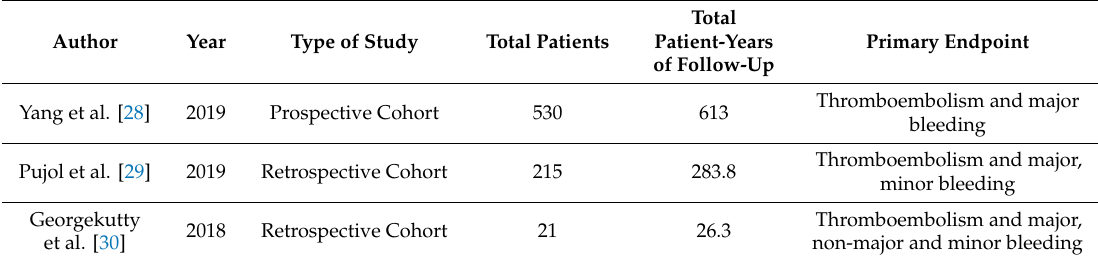
Table 3. Specific characteristics of the included studies and their